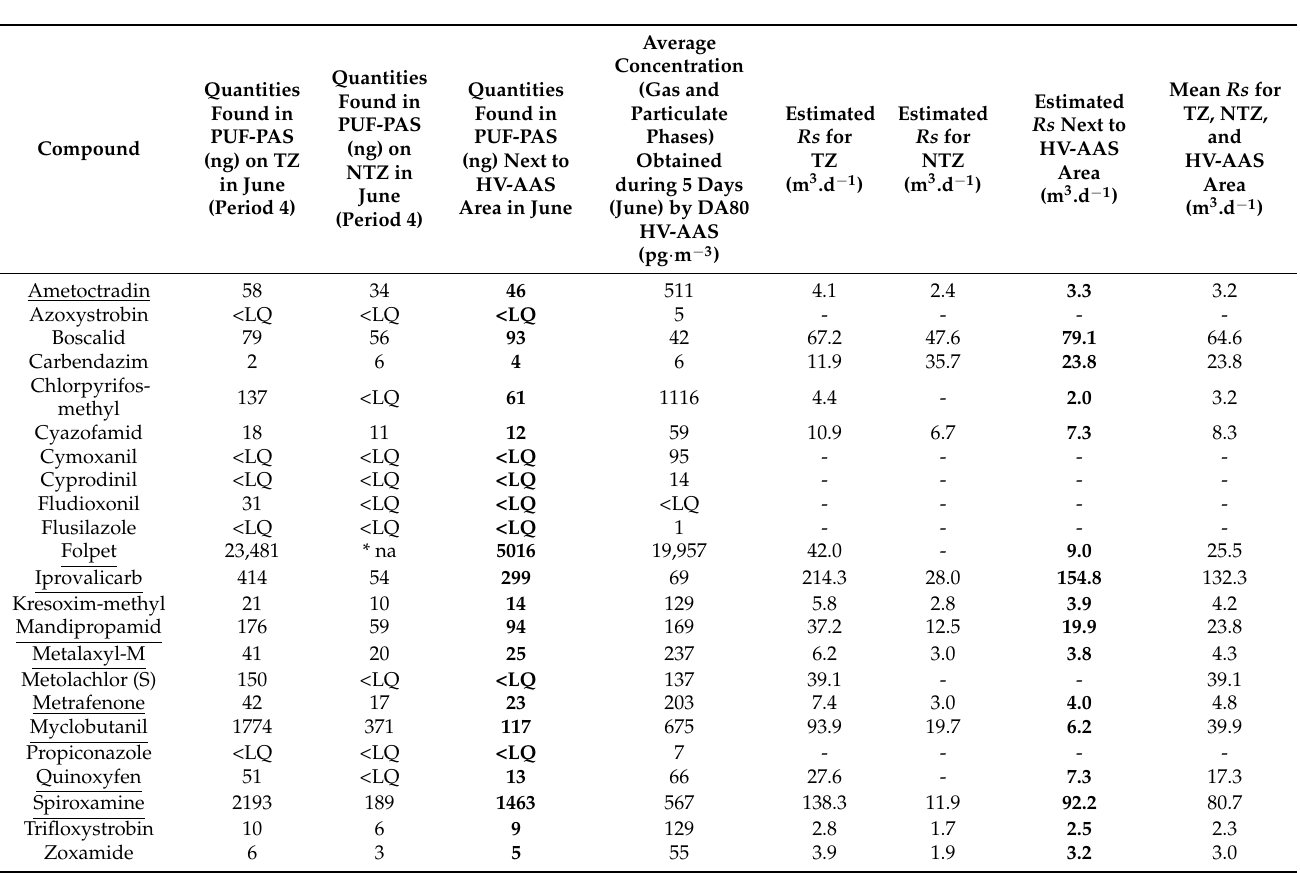
Table 3. Accumulated quantities in PUF-PAS (ng), average pesticide concentrations (pg m − 3 ), and derived individual sampling rates ( Rs ) during the codeployment of passive and active samplers in June 2013 (Gironde,